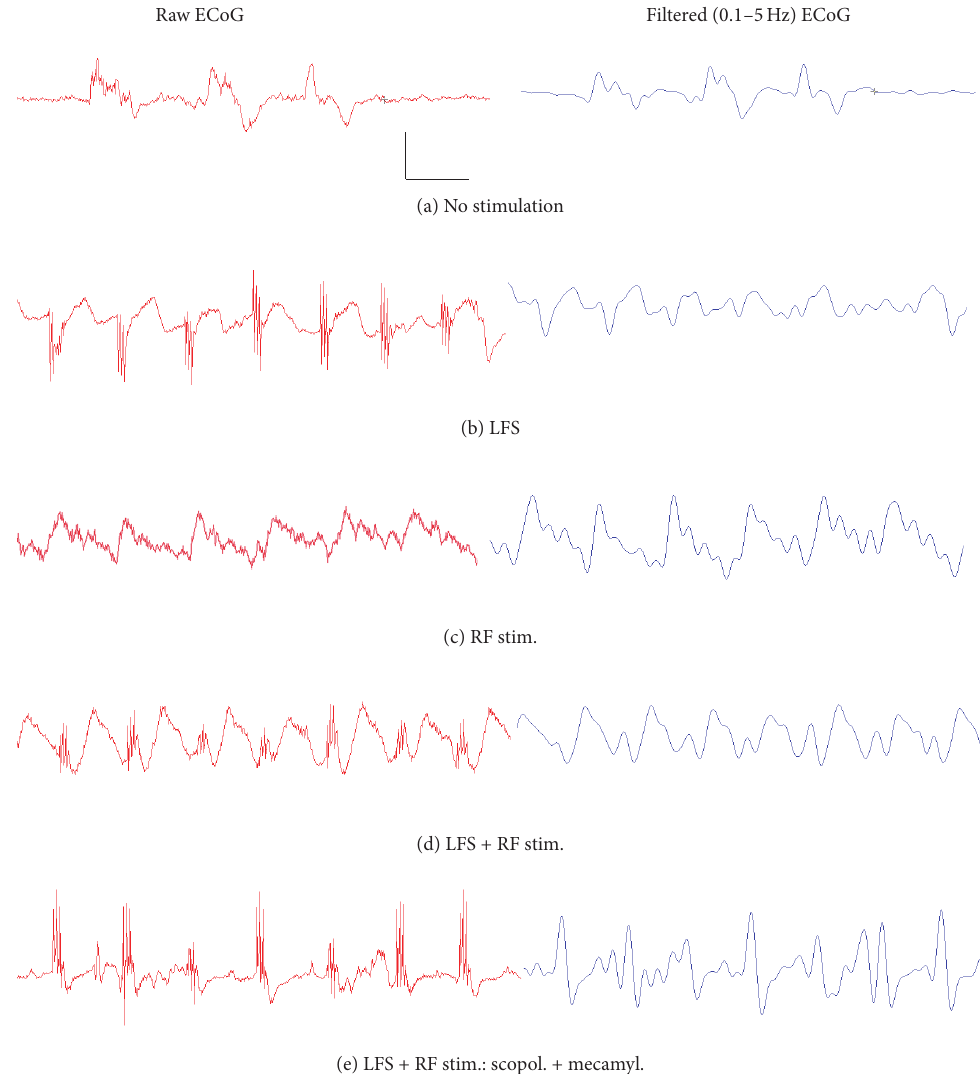
Figure 4: Examples of unfiltered and band-pass filtered (0.1–5 Hz) ECoG activity recorded in V1 of urethane-anesthetized rats. (a) Baseline (prestimulation) ECoG activity showed large, slow oscillations at very low frequencies ( < 1Hz) and periods of electrical quiescence. (b) Application of LFS to the LGN resulted in the appearance of more regular, continuous activity between 0.6 and 2 Hz. (c) RF stimulation alone or (d) paired LFS + RF stimulation resulted in a further increase in the frequency and amplitude of cortical activity. (e) Rats treated with a combination of scopolamine and mecamylamine (scopol., 10 mg/kg + mecamyl., 5 mg/kg) continued to exhibit a more complex, rhythmic activity during LFS + RF stimulation (calibration bars are 0.5 mV and